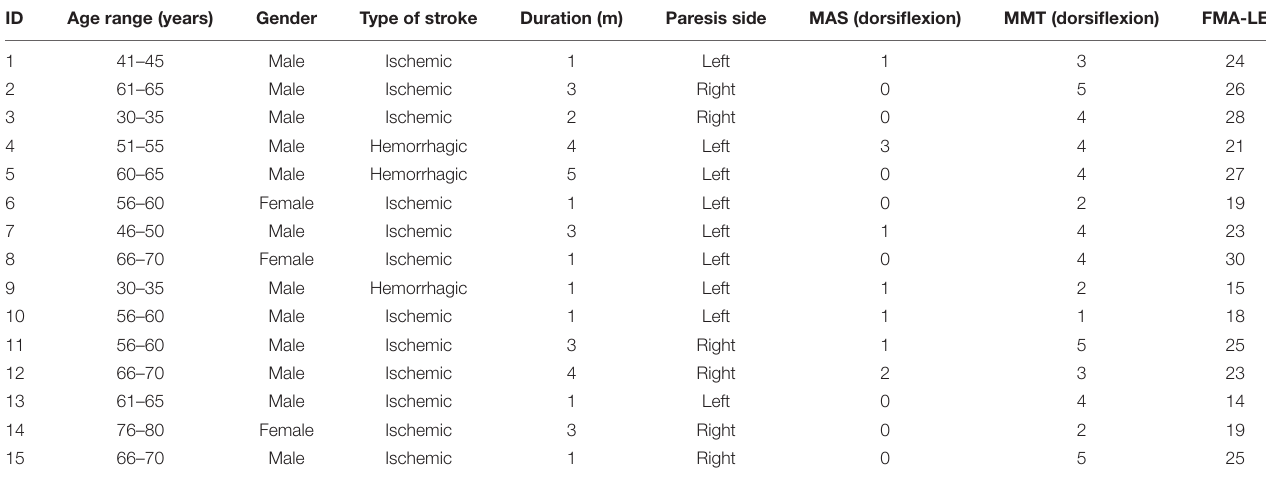
TABLE 1 | Clinical characteristics of the sample